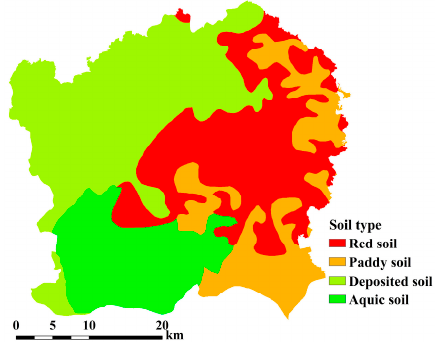
Figure 2. Soil type map of the study area.